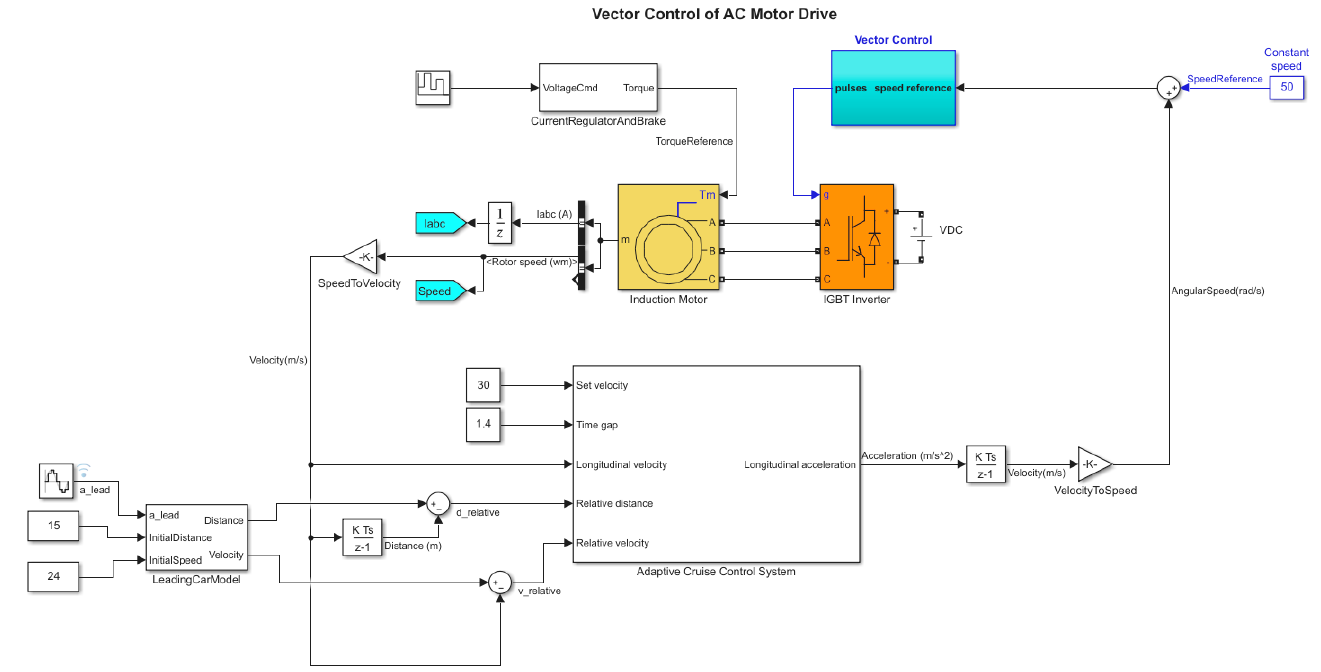
Figure 9. Adaptive cruise control based on indirect vector-controlled induction machine drive system.